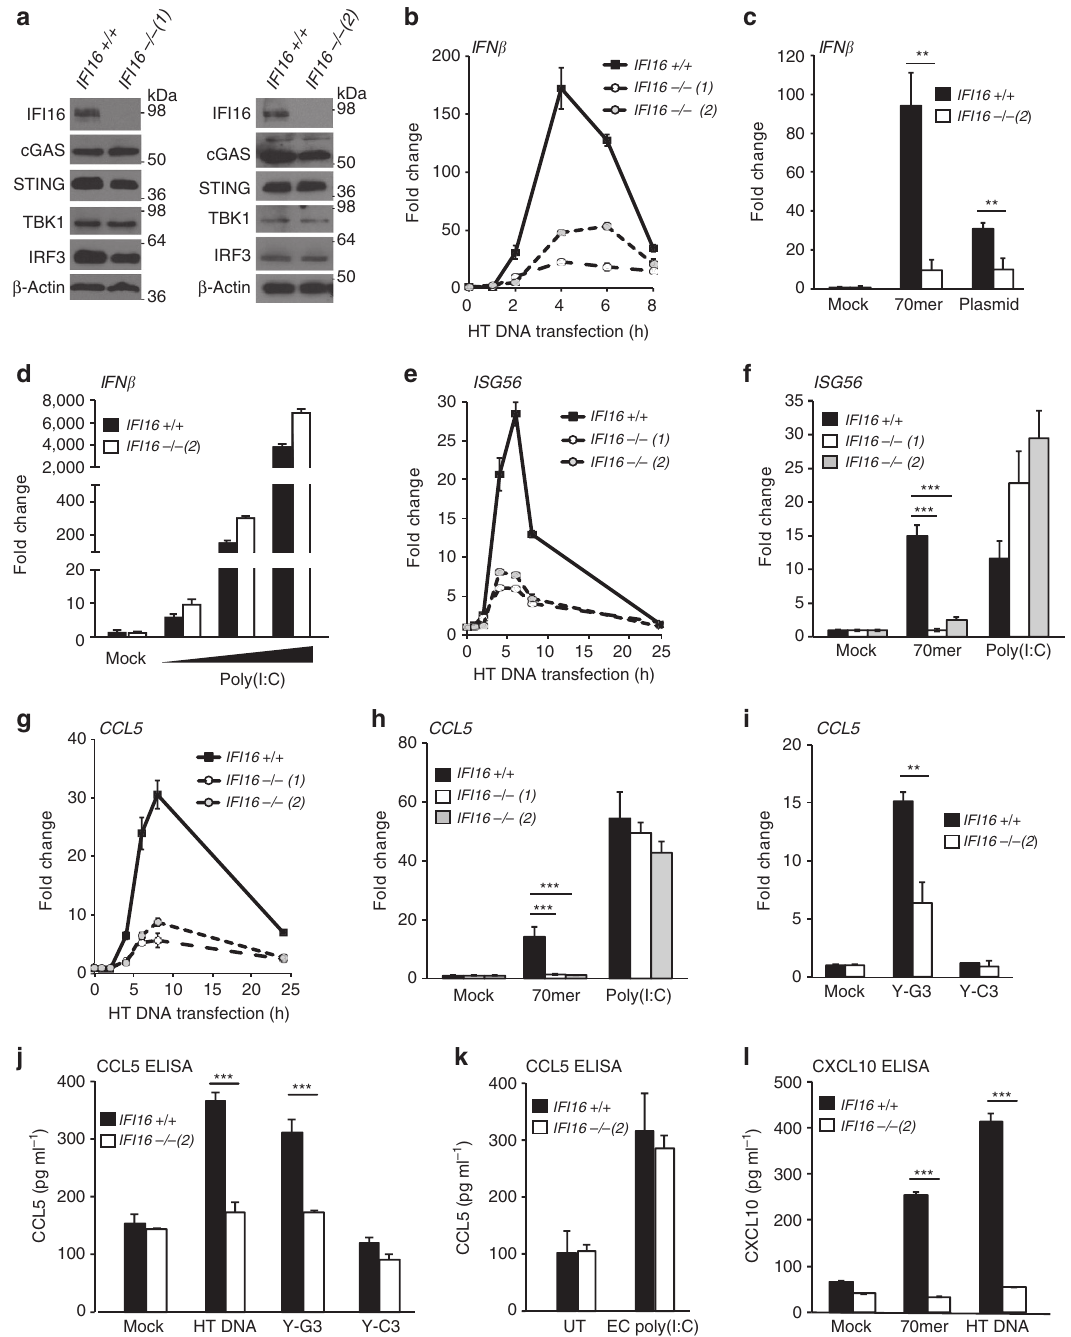
Figure 1 | IFI16 is required for DNA but not RNA sensing in HaCaT keratinocytes. ( a ) Immunoblot analysis of wild-type ( IFI16 þ / þ ) HaCaTand two IFI16 (cid:2) / (cid:2) HaCaT clones. ( b – i ) Quantitative real-time PCR (qRT-PCR) analysis of mRNA expression levels normalized to b -actin mRNA and mock transfection in IFI16 þ / þ and IFI16 (cid:2) / (cid:2) HaCaTcells, as indicated. ( b ) qRT-PCR analysis of IFN- b mRNA expression in IFI16 þ / þ and two IFI16 (cid:2) / (cid:2) HaCaTcells clones transfected with 1 m gml (cid:2) 1 HT DNA for the times indicated. ( c ) qRT-PCR analysis of IFN- b mRNA 6h post transfection with 1 m gml (cid:2) 1 of a 70nt dsDNA oliogonucleotide (70mer) or circular pcDNA3.1 plasmid. ( d ) IFN- b mRNA induction 6h after transfection with 1, 10 or 100ngml (cid:2) 1 poly(I:C). ( e ) Time course of ISG56 mRNA expression following transfection with 1 m gml (cid:2) 1 HT DNA. ( f ) ISG56 mRNA expression 6h post transfection with 1 m gml (cid:2) 1 70mer oligonucleotide or 100ngml (cid:2) 1 poly(I:C). ( g ) qRT-PCR analysis of CCL5 mRNA expression following transfection with 1 m gml (cid:2) 1 HT DNA for the times indicated. ( h ) Relative CCL5 mRNA expression levels 6h post transfection with 1 m gml (cid:2) 1 70mer oligonucleotide or 100ngml (cid:2) 1 poly(I:C). ( i ) CCL5 mRNA expression levels 6h post transfection with 1 m gml (cid:2) 1 of Y-G3 or Y-C3 oligonucleotides. ( j ) Secreted CCL5 (Rantes) protein detected by ELISA in the supernatants of IFI16 þ / þ or IFI16 (cid:2) / (cid:2) HaCaTcells transfected with 1 m gml (cid:2) 1 HT DNA, Y-G3 or Y-C3 DNA for 24h. ( k ) ELISA quantitation of CCL5 protein in supernatants from IFI16 þ / þ and IFI16 (cid:2) / (cid:2) HaCaTcells stimulated with 5 m gml (cid:2) 1 extracellular (EC) poly(I:C) added to the medium for 24h. ( l ) ELISA quantitation of CXCL10 (IP-10) protein in supernatants of IFI16 þ / þ or IFI16 (cid:2) / (cid:2) HaCaT cells transfected with 1 m gml (cid:2) 1 70mer oligonucleotide or HT DNA. All qRT-PCR and ELISA data are presented as mean values of biological triplicates. Error bars indicate s.d. * P o 0.05, ** P o 0.01, *** P o 0.001 Student’s t -test. Data are representative of at least two experiments in two independent IFI16-deficient cell